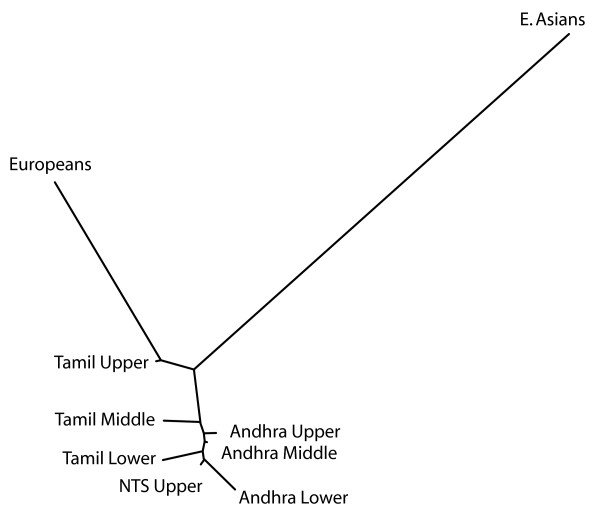
Genetic distances for autosomal data. A neighbor-joining network depicts the genetic distance estimates (DSW) between South Indian castes, Europeans, and East Asians for 45 autosomal STRs.